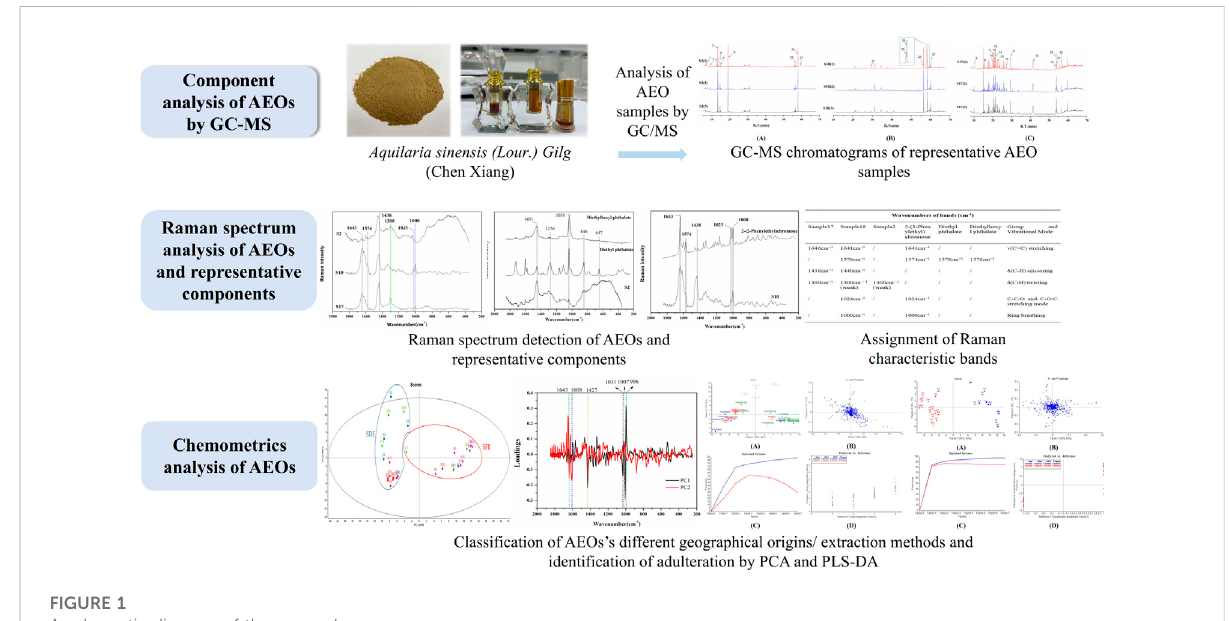
FIGURE 1 A schematic diagram of the research.